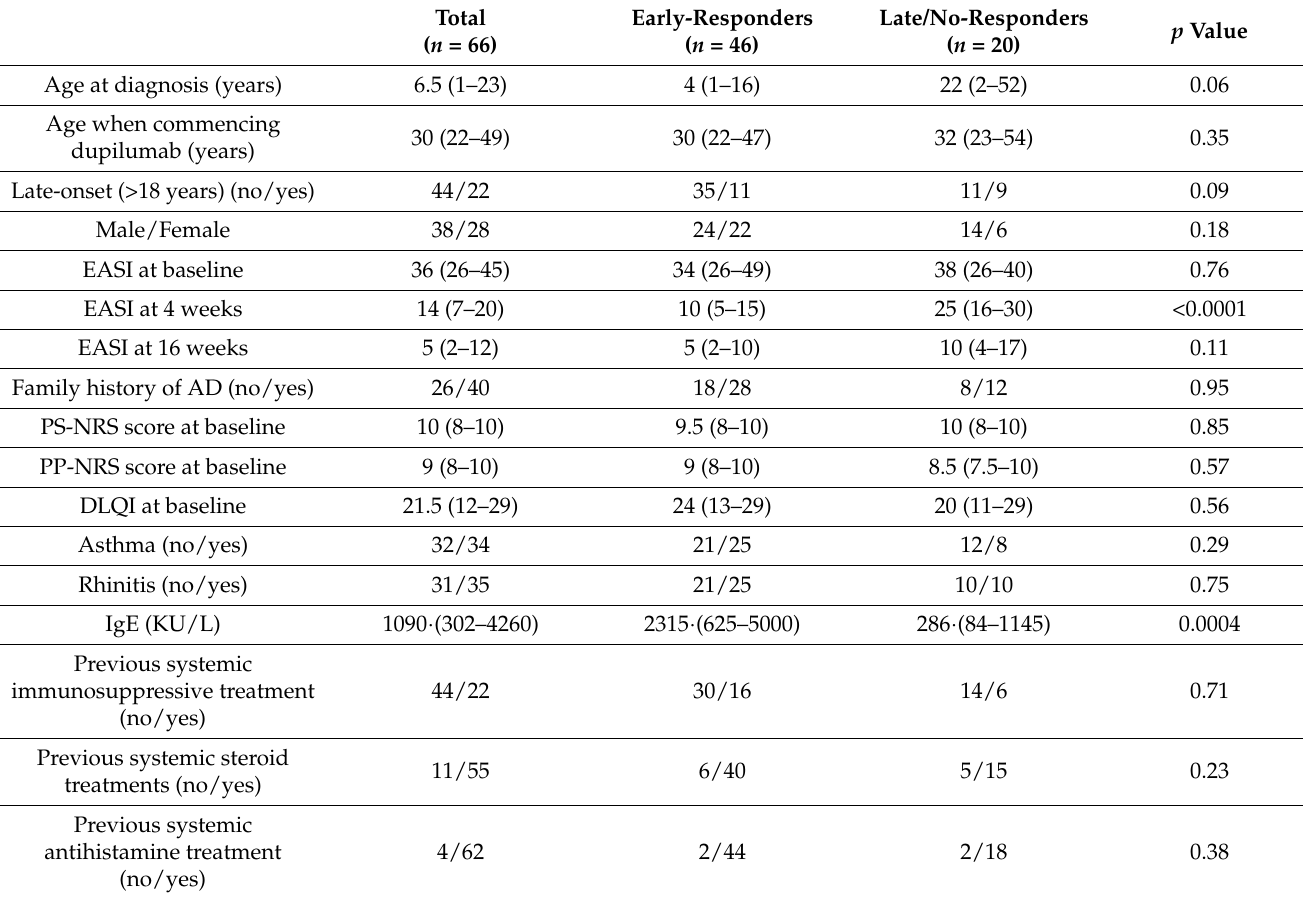
Table 1. Demographic and clinical characteristics of early-responders and late/non-responders.